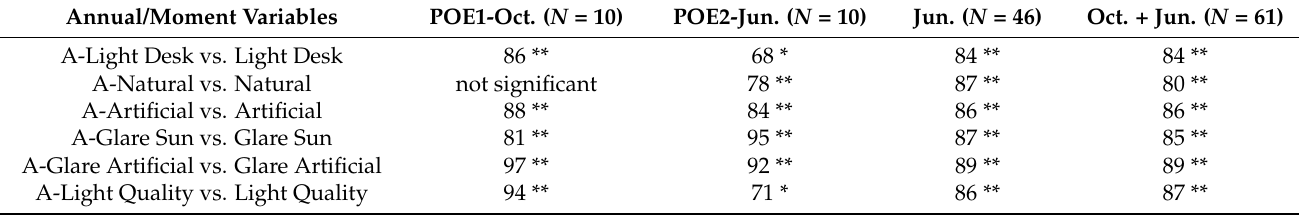
Table 9. Correlation analysis for variables between ‘annual’ and ‘at the